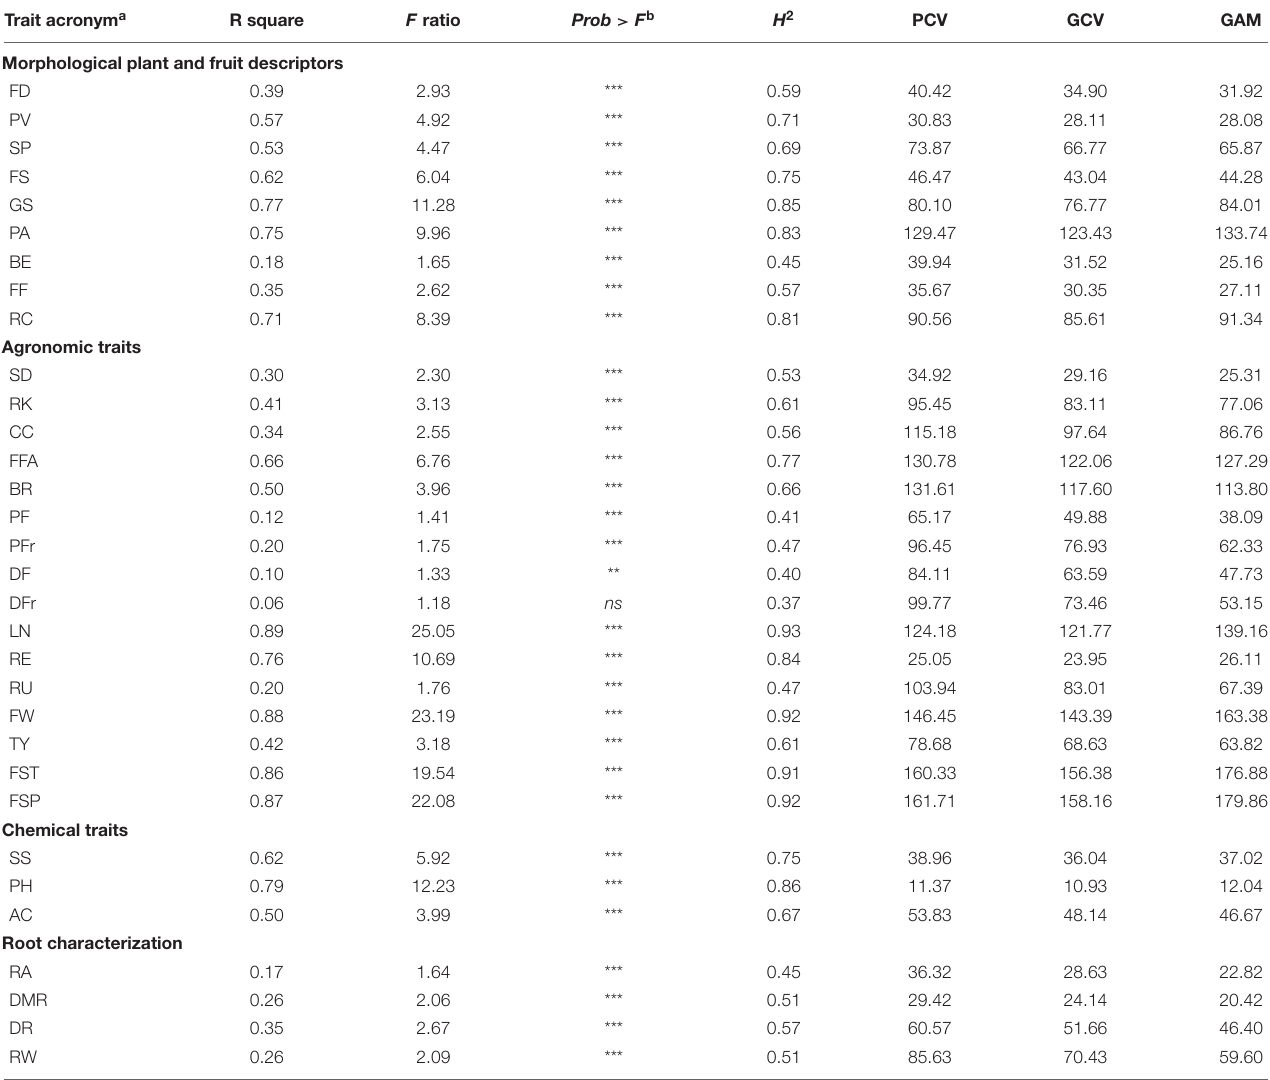
TABLE 3 | Descriptive statistics for pseudo qualitative and quantitative traits, broad sense heritability ( H 2 ), phenotypic and genotypic coefficients of variation (PCV and GCV, respectively), and genetic advance as percent of population mean (GAM), for traits analyzed in three treatments (control, water stress, nitrogen stress) and two environments (Monsampolo del Tronto, Italy; Alcàsser, Spain) on 42 tomato